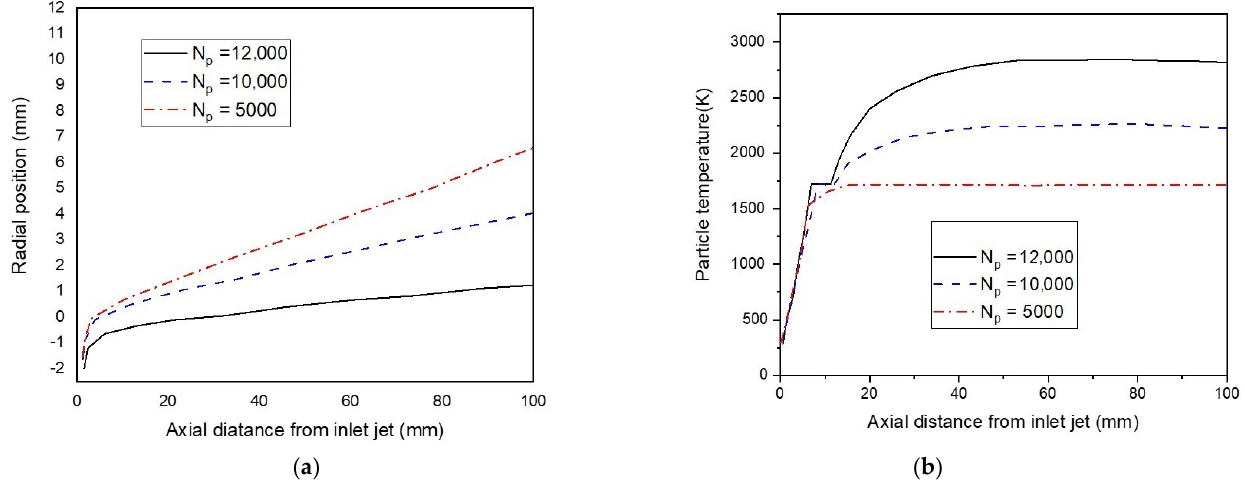
Figure 15. The radial trajectory of particles ( a ) and the particle’s temperature ( b ), under a different number of particles (N p = 5000, 10,000, and 12,000).